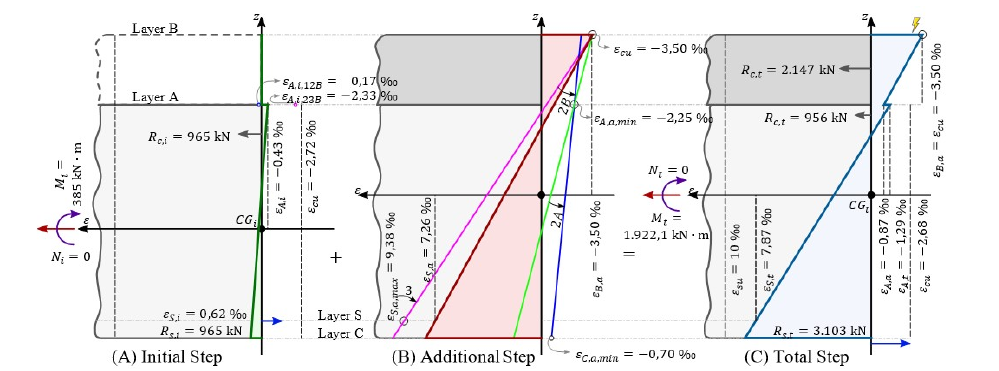
Figure 15. Strain diagram in ULS for the beam-2.